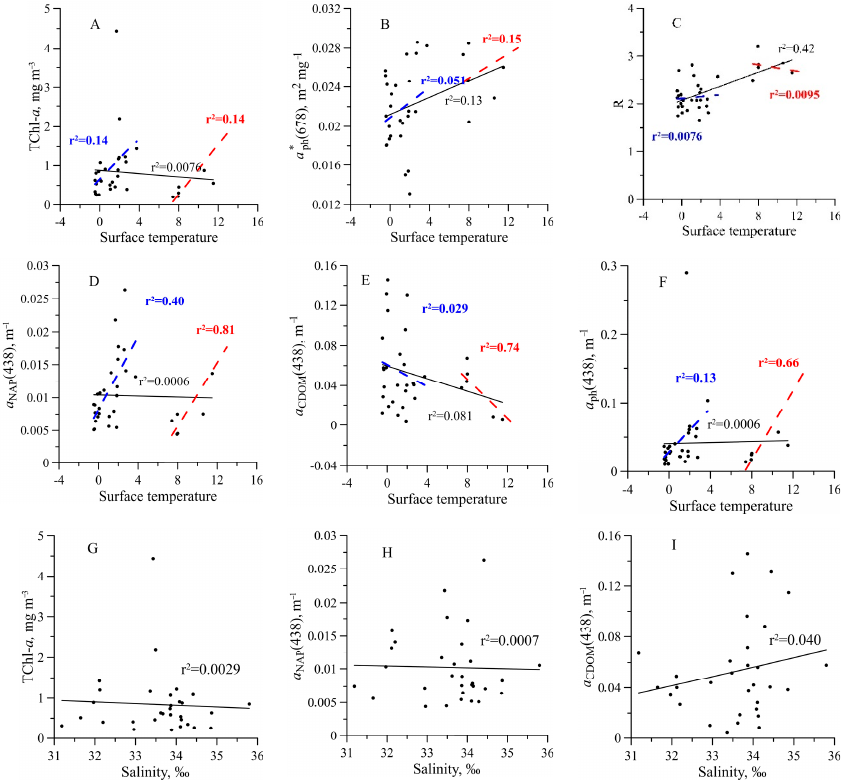
Figure 10. Influence of the surface temperature ( A – F ) and salinity ( G – I ) on the sum of chlorophyll a and phaeopigments concentration (TChl- a ) ( A , G ), TChl- a specific light absorption coefficient of phytoplankton at 678 nm ( 𝑎 (cid:3043)(cid:3035)∗ (678) ) ( B ), the ratio between phytoplankton light absorption coeffi- cients at blue and red peaks (R) ( C ), non-algal particles light absorption coefficient at 438 nm ( a NAP ( 438 ) ( D , H ), coloured dissolved organic matter light absorption coefficient at 438 nm ( a CDOM ( 438 ) ) ( E , I ) and light absorption coefficient of phytoplankton at 438 nm ( a ph ( 438 ) ) ( F ) in the surface layer of the Southern